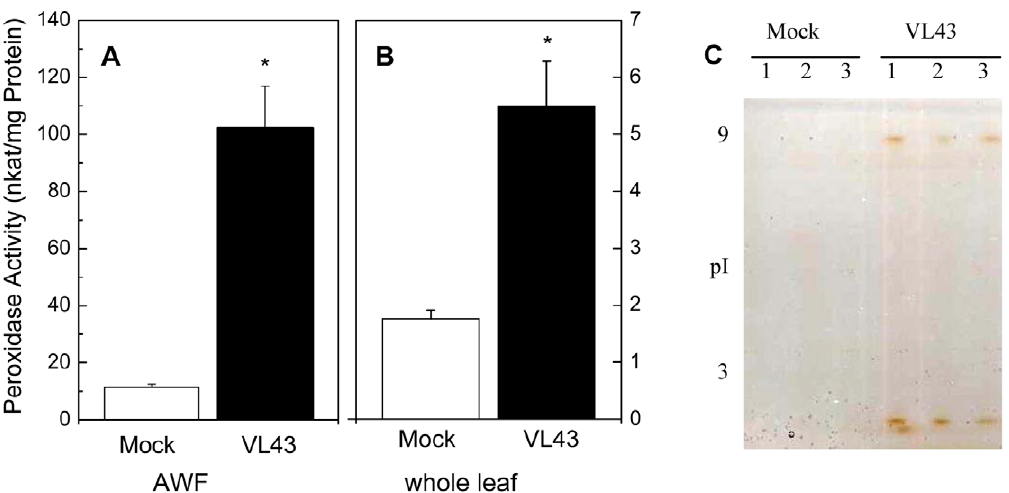
Figure 3. Peroxidase activity in apoplastic (A) and whole leaf extracts (B) and peroxidase activity staining in AWF (C). Data are shown for mock (white columns) and Verticillium longisporum (VL43) infected Arabidopsis plants (black columns) 25 days post infection. Data indicate means (n=6, 6 SE). *indicate significant differences between mock- and VL-infected plants. For protein separation each lane of an isoelectric focusing gel (pH 3 to 9) was loaded with 3.5 m g AWF protein. Each of the three lanes of mock and VL43-infected plants corresponds to an independent biological